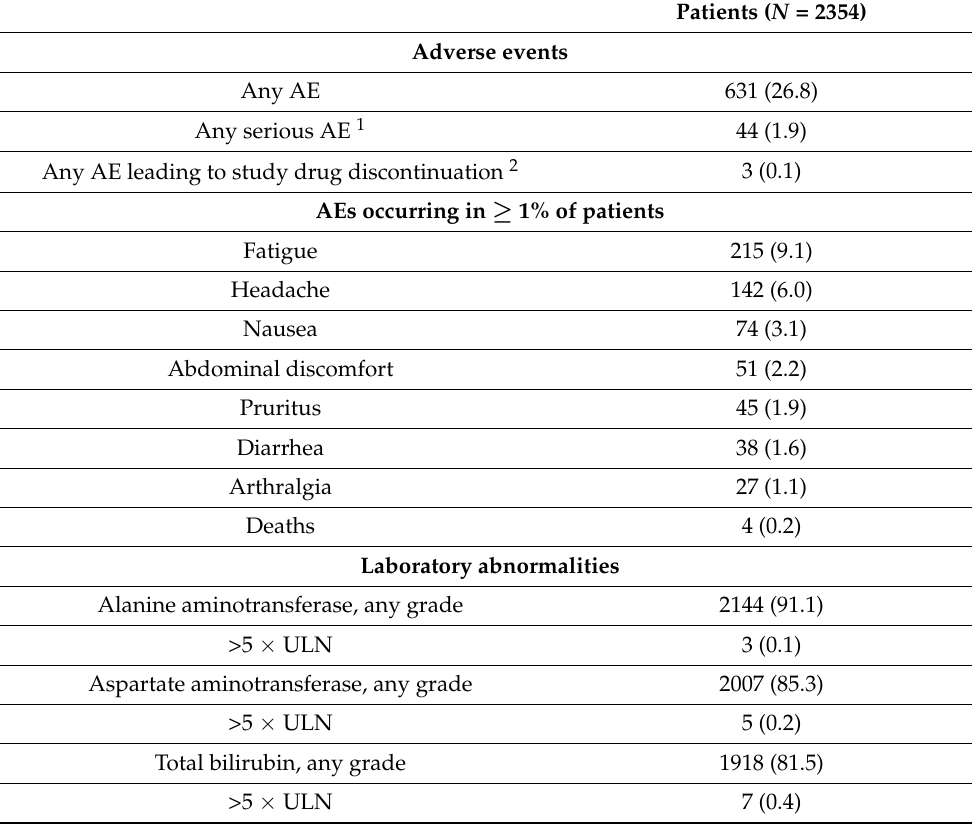
Table 2. Treatment-emergent adverse events and post-baseline laboratory abnormalities (safety